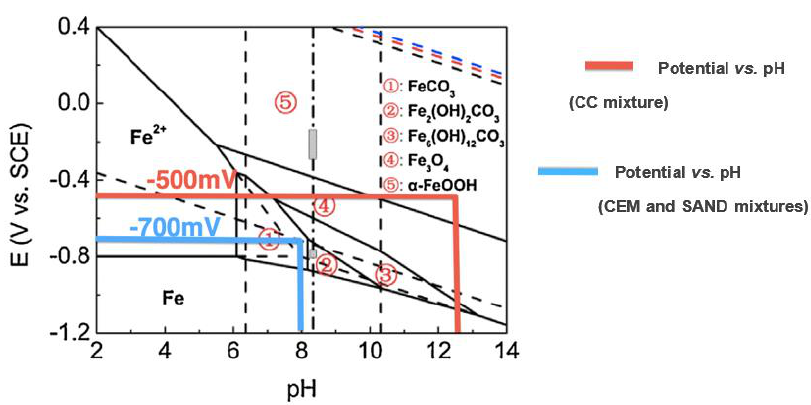
Figure 10. Pourbaix diagram of Fe-H 2 O-CO 2 system adapted from Pourbaix, 1973, [81]. It is recognized that distinct species (solid, ionic and soluble) are involved when concrete paste is considered. With this, a potential-pH system of Fe-H 2 O [40,75] no cor- rectly represents possible reactions. It is remarked that pH values neighboring rebar is extremely difficult since pH drop locally or punctually occurs. Due to this, no experimental measurements were conducted. A pH bulk measurement was not detected.